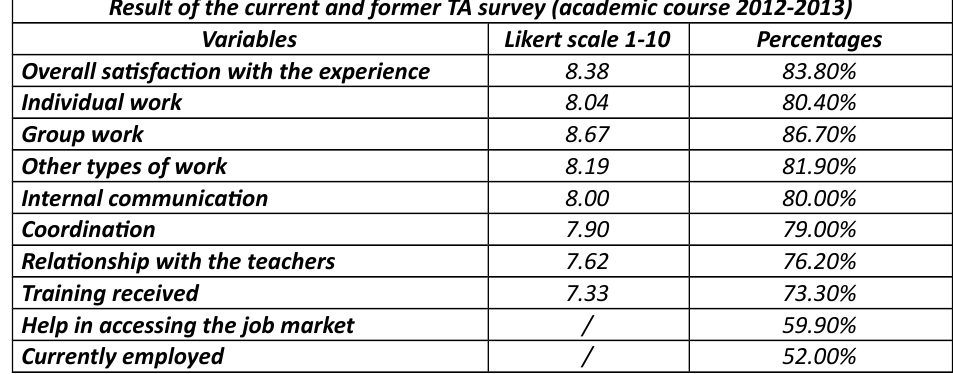
Table 2. The column “Likert scale” represents the direct score obtained from the survey (10 point scale), whereas the last column represents the percentage score used to compare the diferent scales of the